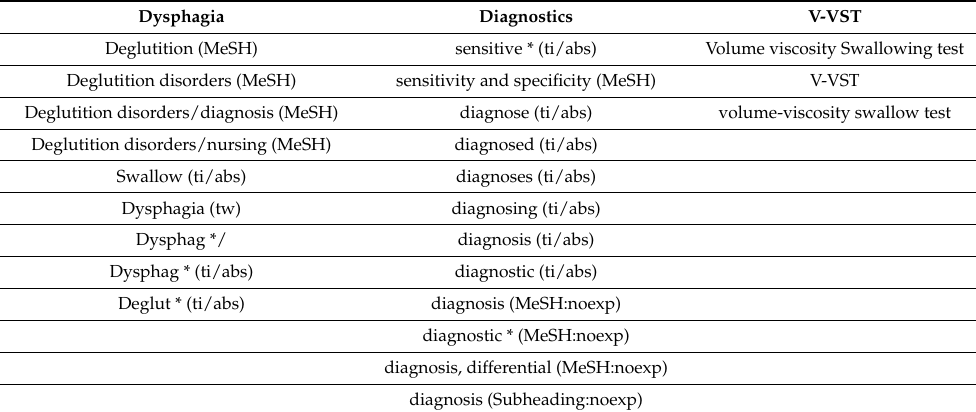
Table 1. Search terms used in the bibliographic search for PubMed. Our search strategy combined 3 arms that merged the terms with the Boolean ”or” inside each arm and the Boolean “and” between arms for the systematic review (SR). For the scoping review (ScR), we only applied the V-VST